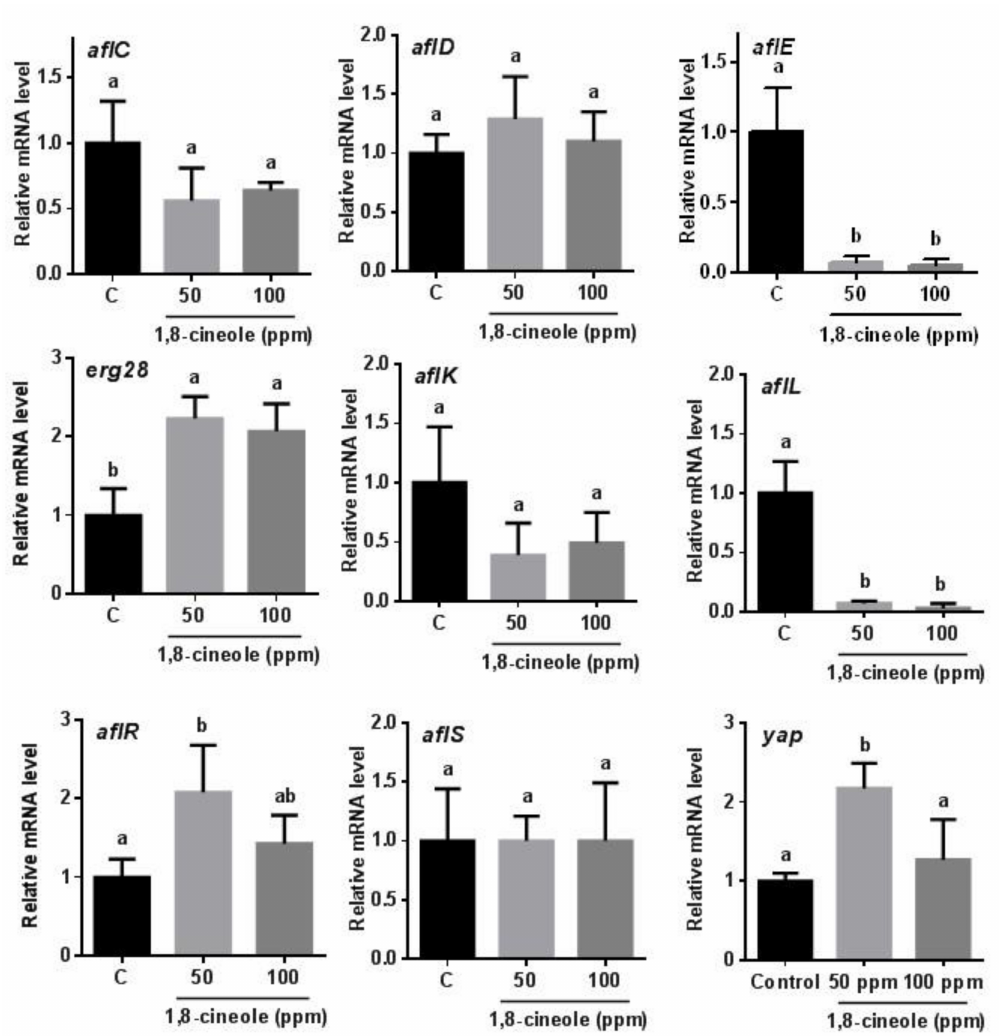
Figure 4. Expression of genes ( aflC , aflD , aflE , aflK , aflL , aflR , aflS , and yap ) involved in aflatoxin biosynthesis in Aspergillus flavus treated with 1,8-cineole. An ergosterol biosynthetic gene, erg28 , was comparatively measured after treatment with 1,8-cineole. Different letters above the same column indicate significant differences from the control group ( p <